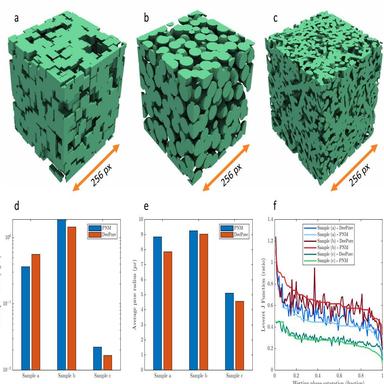
Independent verification of model using three artificial porous structures completely outside the training, validation and testing dataset. (a) overlapped pack of cubes, (b) partially overlapped pack of spheres, (c) fibrous media of straight cylindrical rods, (d) comparing the absolute permeability of three images obtained by PNM and DeePore, (e) comparing the average pore radius of three images obtained by PNM and DeePore, and (f) comparison of Leveret J function of three porous samples simulated by PNM a